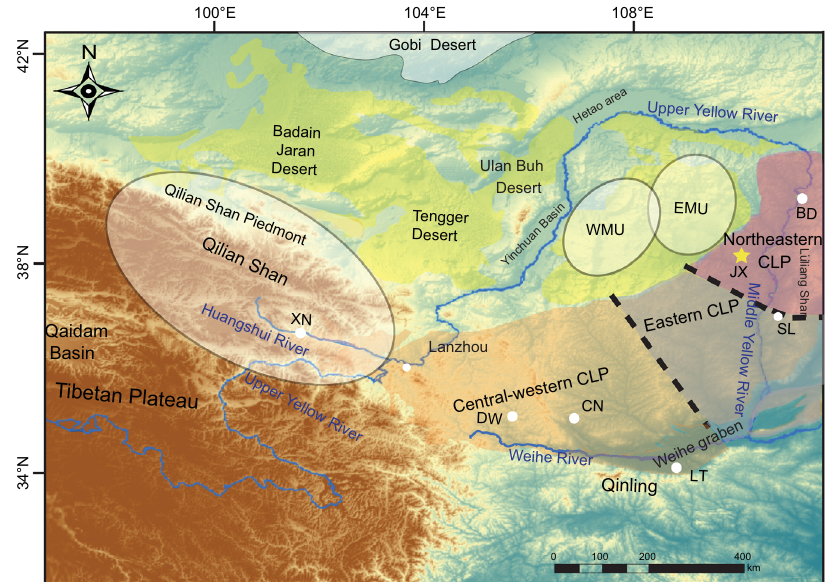
Fig. 1 Map of detrital zircon sample sites in the Chinese Loess Plateau (CLP) and potential sources (modi fi ed from Ref. 16 ). The yellow star indicates the location of the Jiaxian site (JX). White dots indicate the locations of other loess-Red Clay sites. CN Chaona, BD Baode, DW Dongwan, LT Lantian,